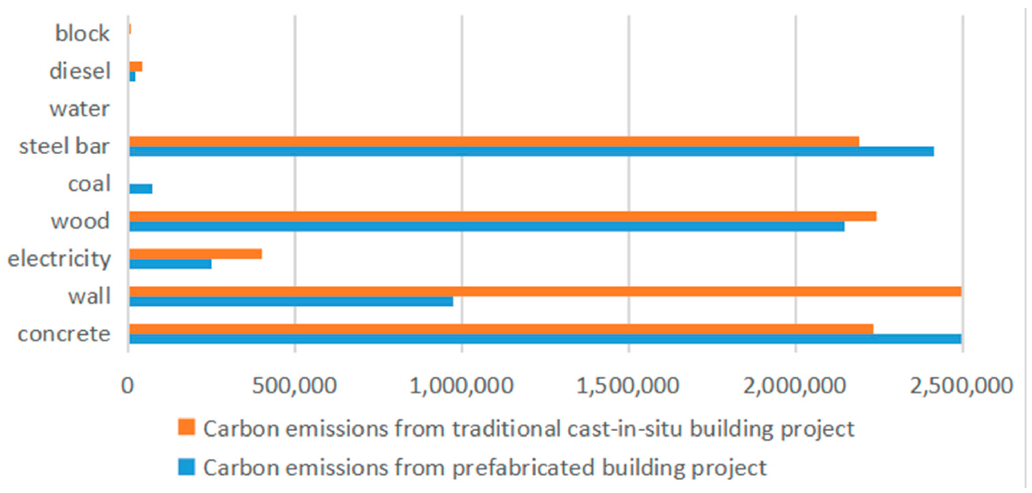
Figure 4. Bar chart of carbon emissions differences in the field installation stage.